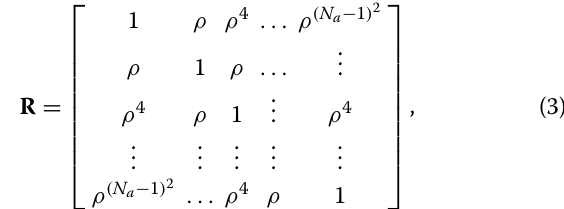
the class n . The total number of active users is given by (cid:2) N | C | . The k th user in the n th user K = n n = 1